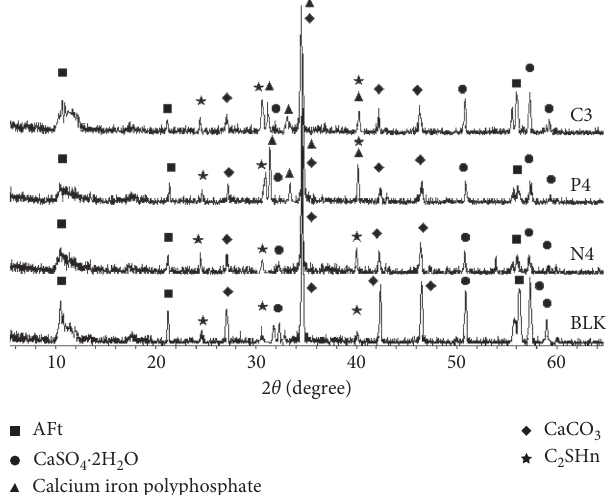
Figure 6: X-ray diffraction pattern of